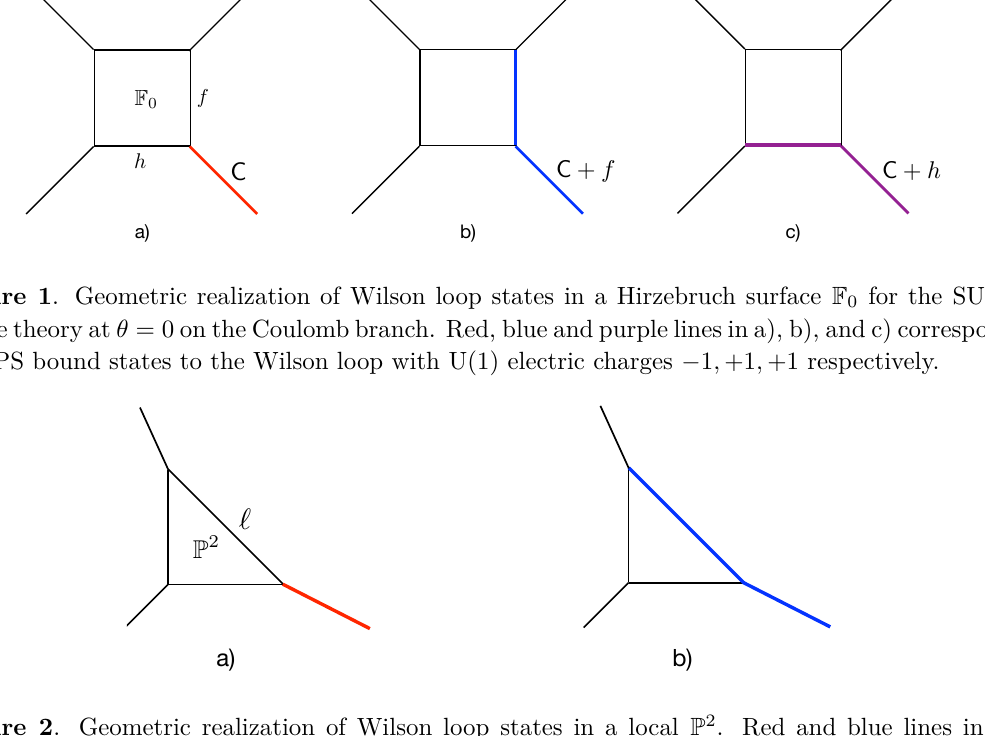
Figure 2 . Geometric realization of Wilson loop states in a local P 2 . Red and blue lines in a) and b) correspond to BPS bound states to the Wilson loop with U(1) electric charges − 1 and +2 respectively on the Coulomb